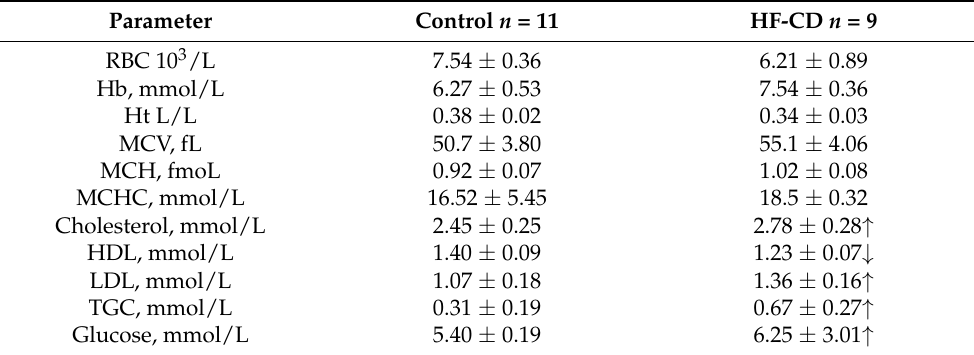
Table 1. The selected results of hematological and biochemical blood tests of control pigs and pigs fed for 3 months of HF-CD [1]. The results are presented as an average ±